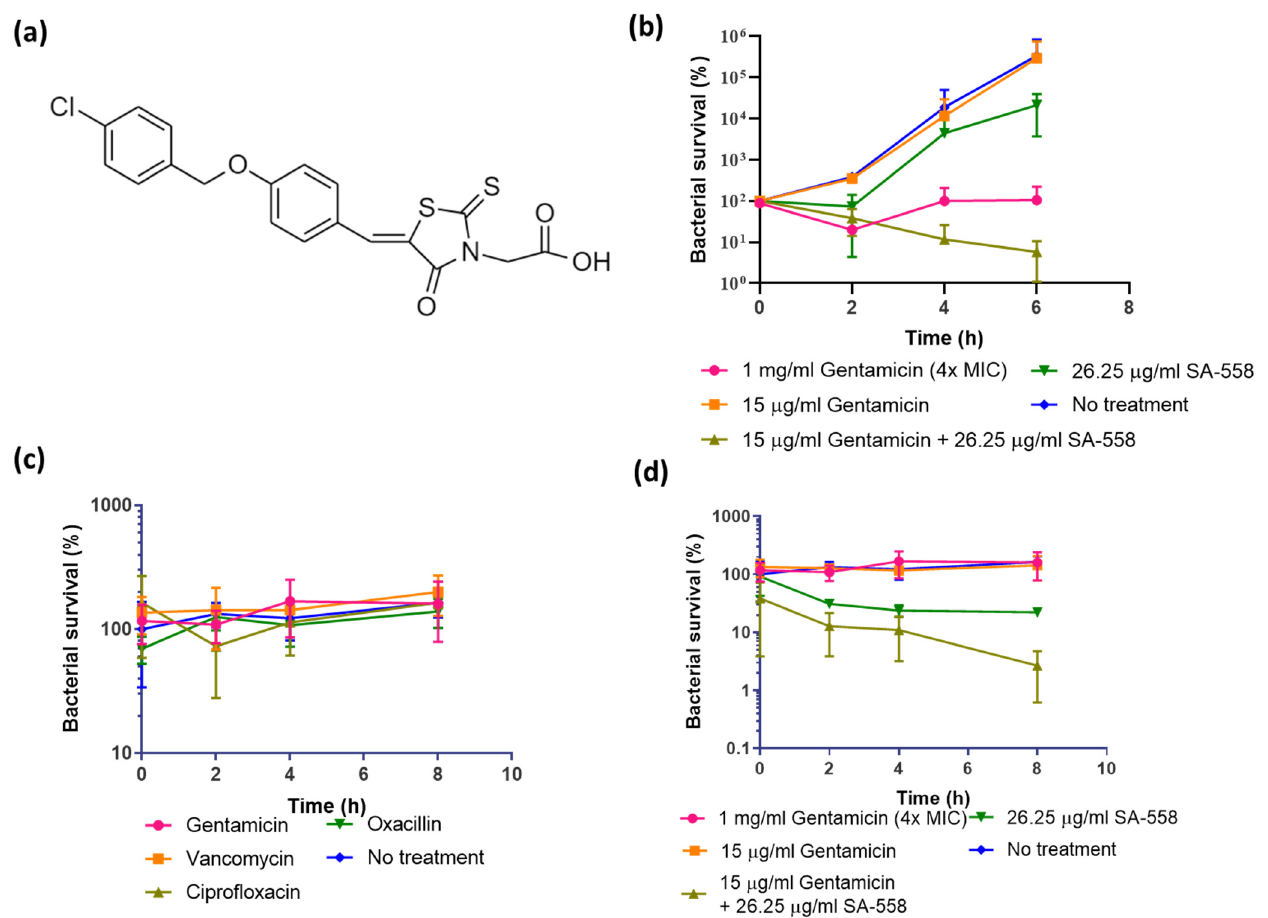
Figure 1. Antibacterial activity of SA-558 against S. aureus Mu3 strain in different growth phases. ( a ) Structure of SA-558; ( b ) Antimicrobial activity of SA-558 against exponential phase S. aureus; ( c ) Stationary phase S. aureus resisted killing by various antibiotics. Gentamicin (1 mg/mL), vancomycin (2 µg/mL), cipro fl oxacin (125 µg/mL), oxacillin (4 mg/mL). Four-fold MIC of antibiotics were used in the assay; ( d ) Antimicrobial activity of SA-558 against stationary phase S. aureus . Means ± SD from three independent experiments are presented.